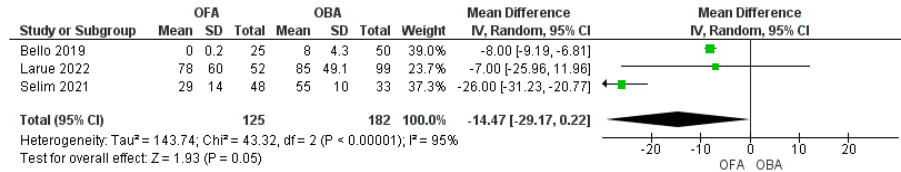
opioid − based anesthesia [18–20].